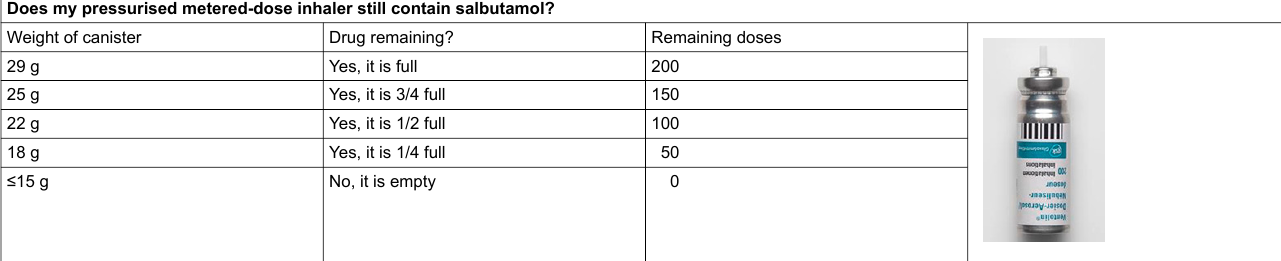
Table 2: Practical table to determine if the canisters of the salbutamol pressurised metered-dose inhalers are empty. Does my pressurised metered-dose inhaler still contain salbutamol? Weight of canister Drug remaining? Remaining doses 29 g Yes, it is full 200 25 g Yes, it is 3/4 full 150 22 g 18 g ≤15